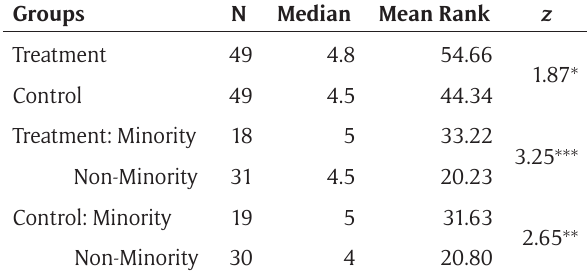
Table 1: Comparisons of groups on Frog Activity Interest